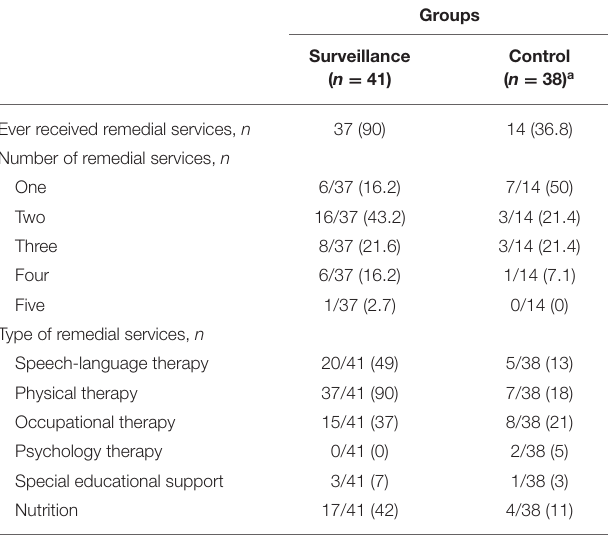
TABLE 2 | Participants’ characteristics relating to the use of remedial services.